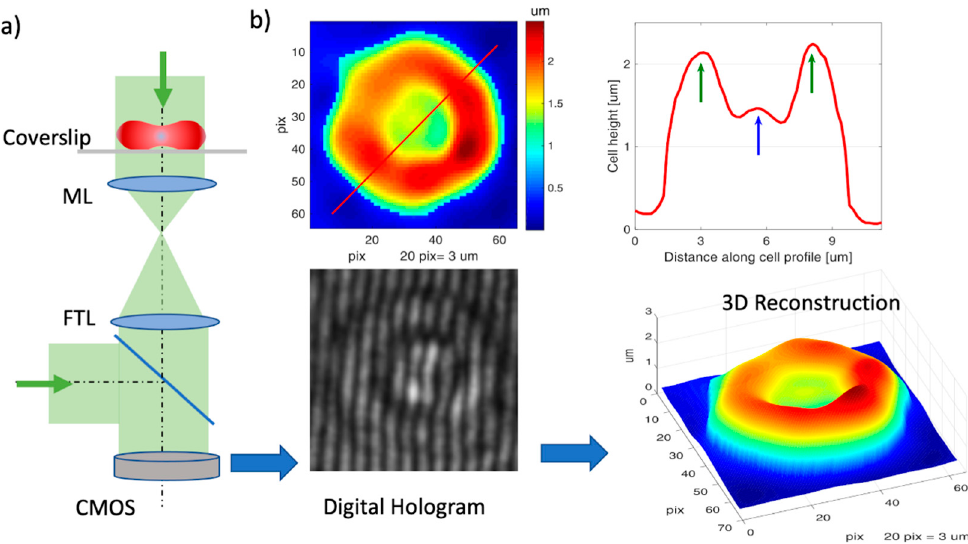
Figure 2. Digital holographic microscopy (DHM) for 3D RBC imaging. ( a ) Schematic of the DHM setup. Green arrows: laser beam; ML: microscope lens, TL: tube lens, CMOS: camera sensor; ( b ) recorded digital hologram on CMOS and 3D reconstruction (bottom); height profile of the cell (top right) along the red line shown in reconstruction (top left).